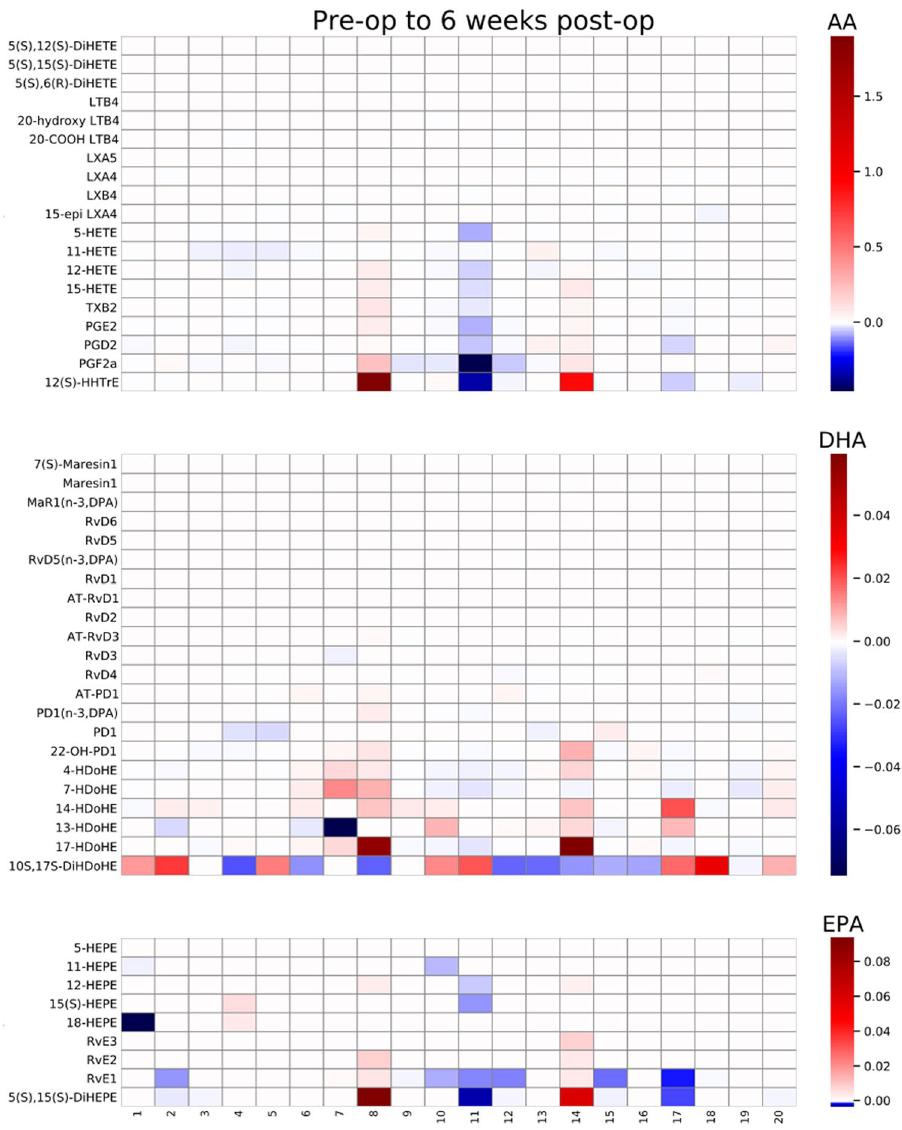
Figure 4. Centrifuged CSF supernatant heatmaps for AA, DHA, and EPA derived metabolite pathway changes from pre-op to 6 weeks post-op (N = 20). Patients are listed as numbers on the x-axis for each heatmap. Heatmap scale numbers represent natural log ratios of analyte concentrations from pre-op to 6 weeks